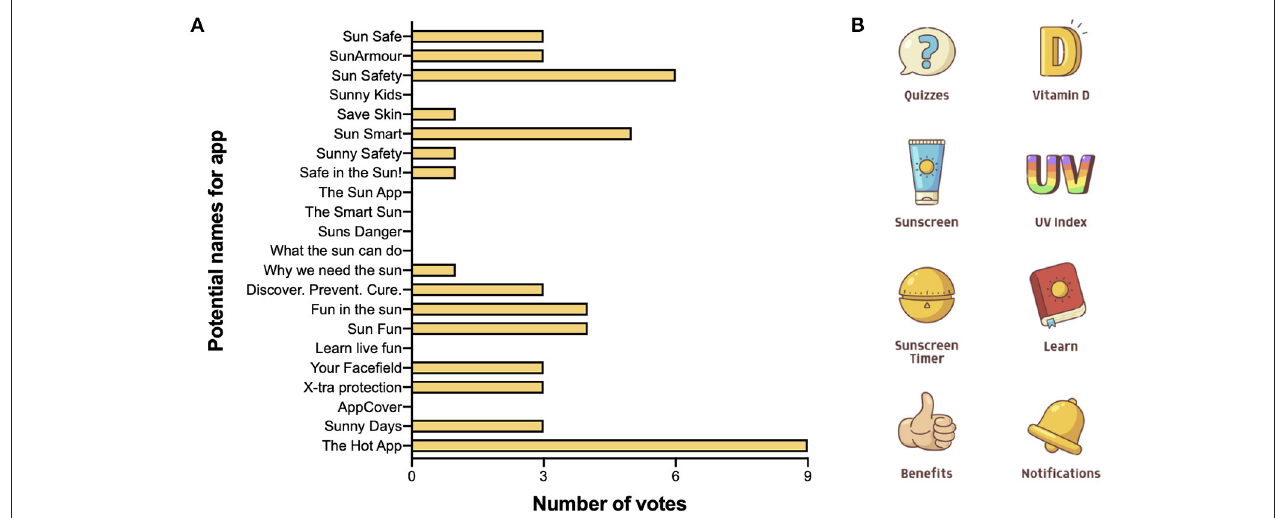
FIGURE 5 | Co-researcher preferred name and artwork for the Sun Safe app. (A) A secret ballot was conducted during Workshop 2, asking co-researchers to nomimate their 3 preferred names for the developed wireframe, with 18 co-researchers providing a total of 50 votes. (B) App artwork (icons) developed through the 99Designs